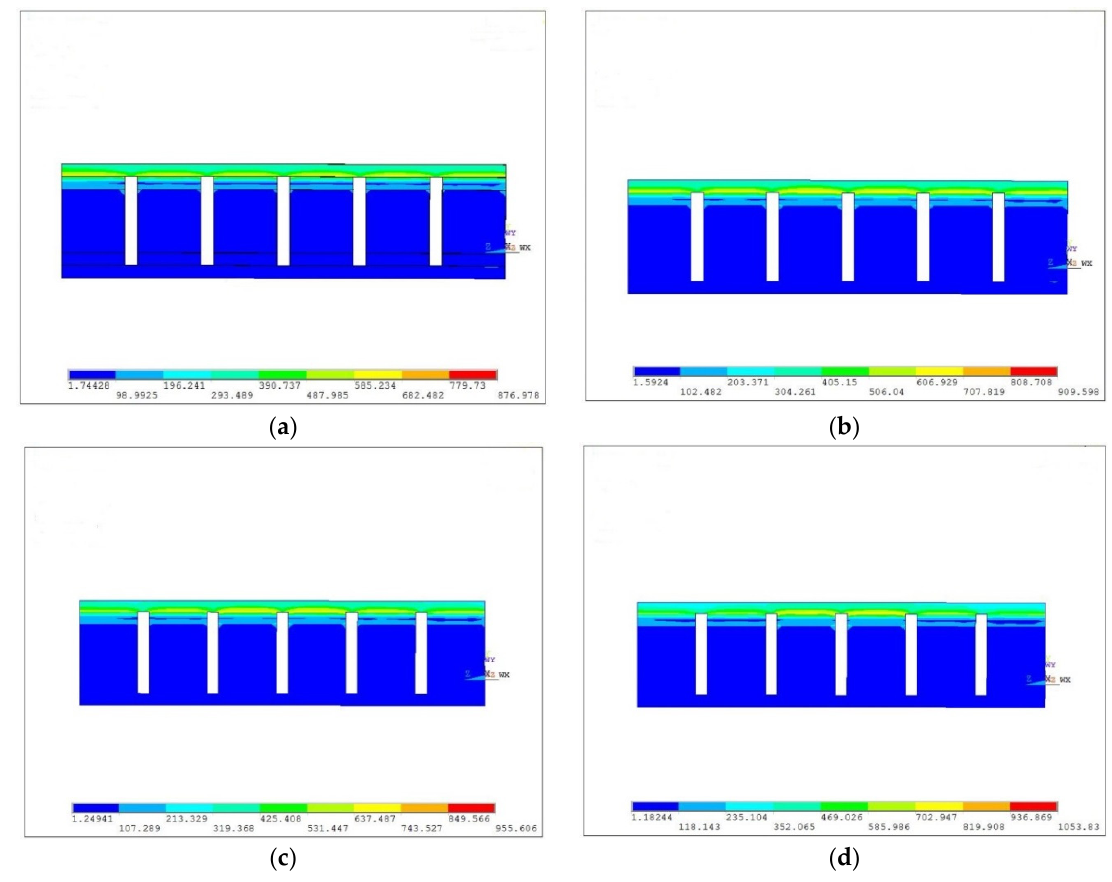
Figure 8. The evolution of thermal stress distribution on F2 at different heating powers and different heating uniformities (Unit: MPa). ( a ) P = 13.23 W U f = 100%; ( b ) P = 13.23 W U f = 50%; ( c ) P = 13.23 W U f = 30%; ( d ) P = 13.23 W U f = 10%.